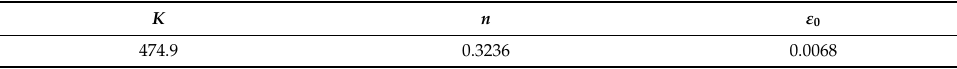
Table 8. Swift constitutive equation coefficients of material 5754O.